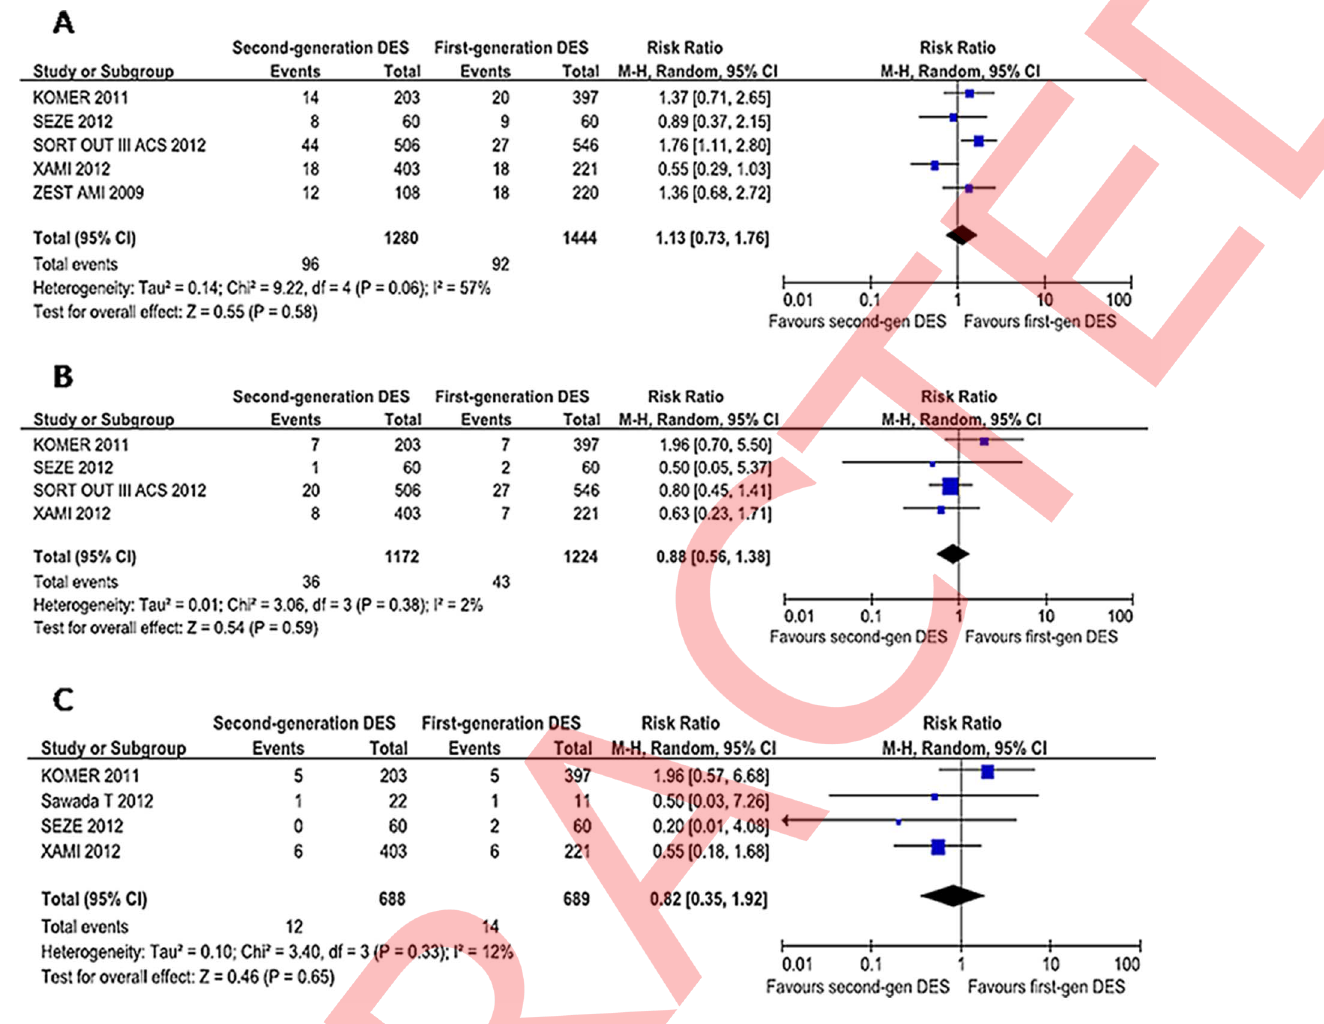
Figure 2. Pooled risk ratios of second-generation versus first-generation drug-eluting stents for acute coronary syndrome for major adverse cardiac events (A), all-cause mortality (B), and cardiac death (C). CI = confidence intervals; DES=drug-eluting stents; M–H = Mantel-Haenszel.